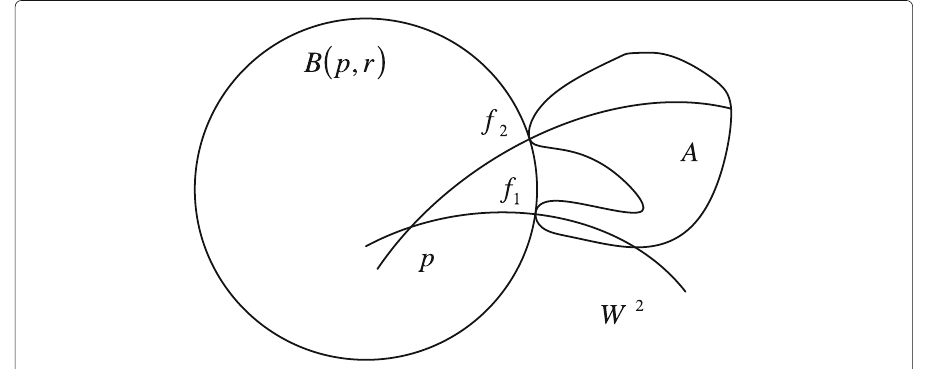
Fig. 1 Uniqueness of foot points in a convex